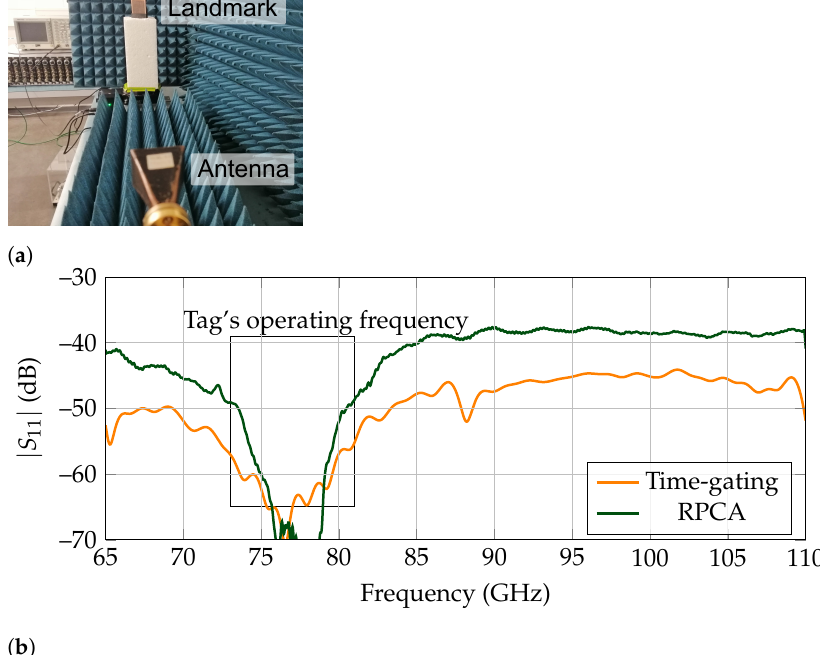
Figure 3. Free-space measurement for low-Q landmark. ( a ) Measurement set-up. ( b ) Backscattered frequency